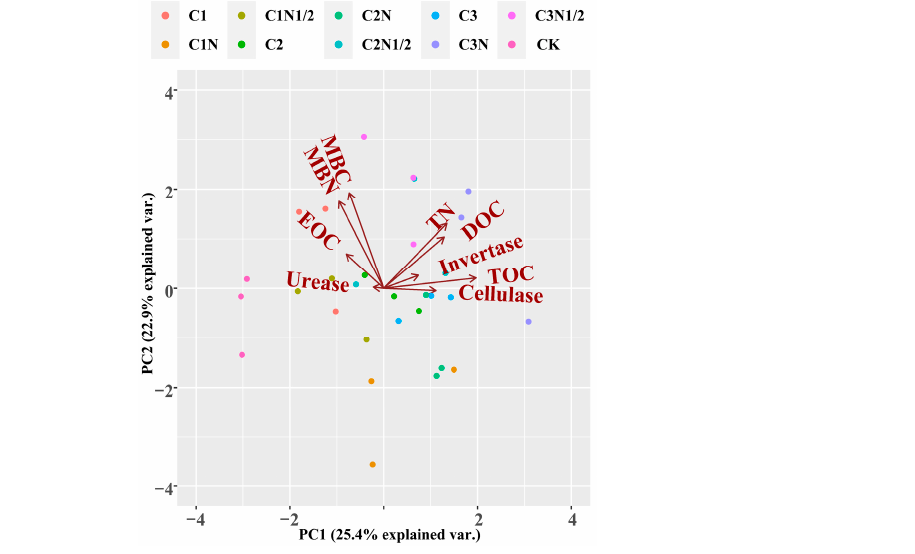
Table 4. Agronomic traits of wheat under different